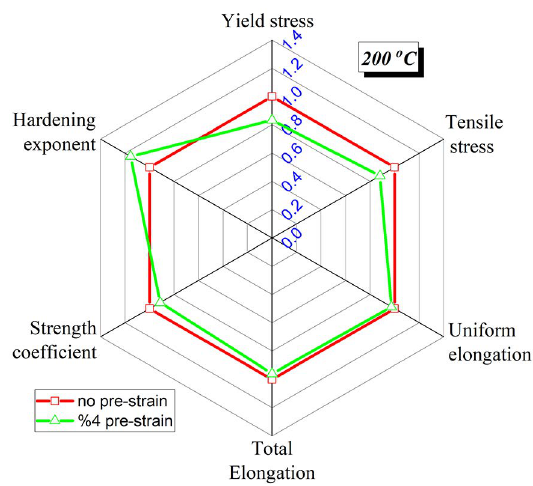
Figure 17. Comparison of mechanical properties at 200